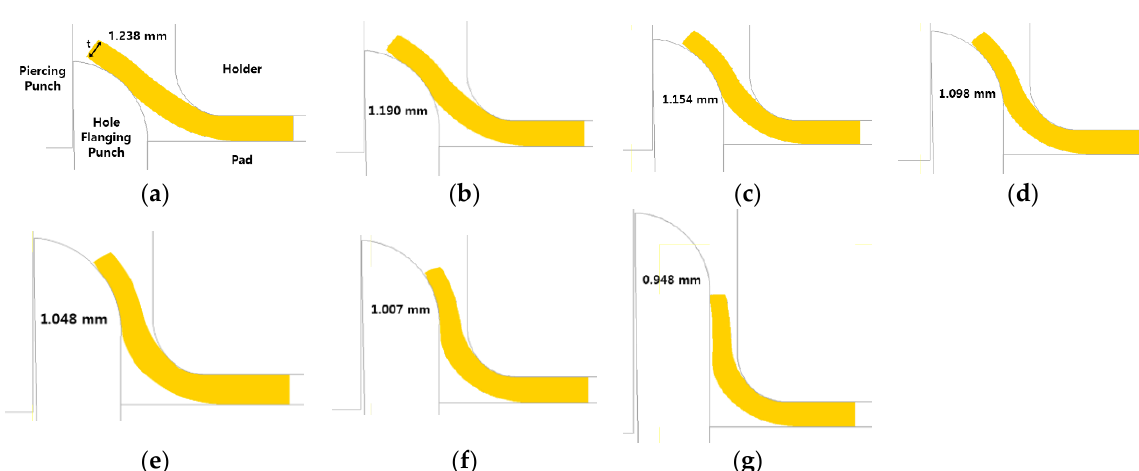
Figure 6. Change in phase distribution with respect to position during the piercing and hole-flang- ing process; ( a ) measurement positions of temperature and phase distribution; ( b ) percentage phase distribution at hole flanging zone; ( c ) percentage phase distribution at quenching zone.